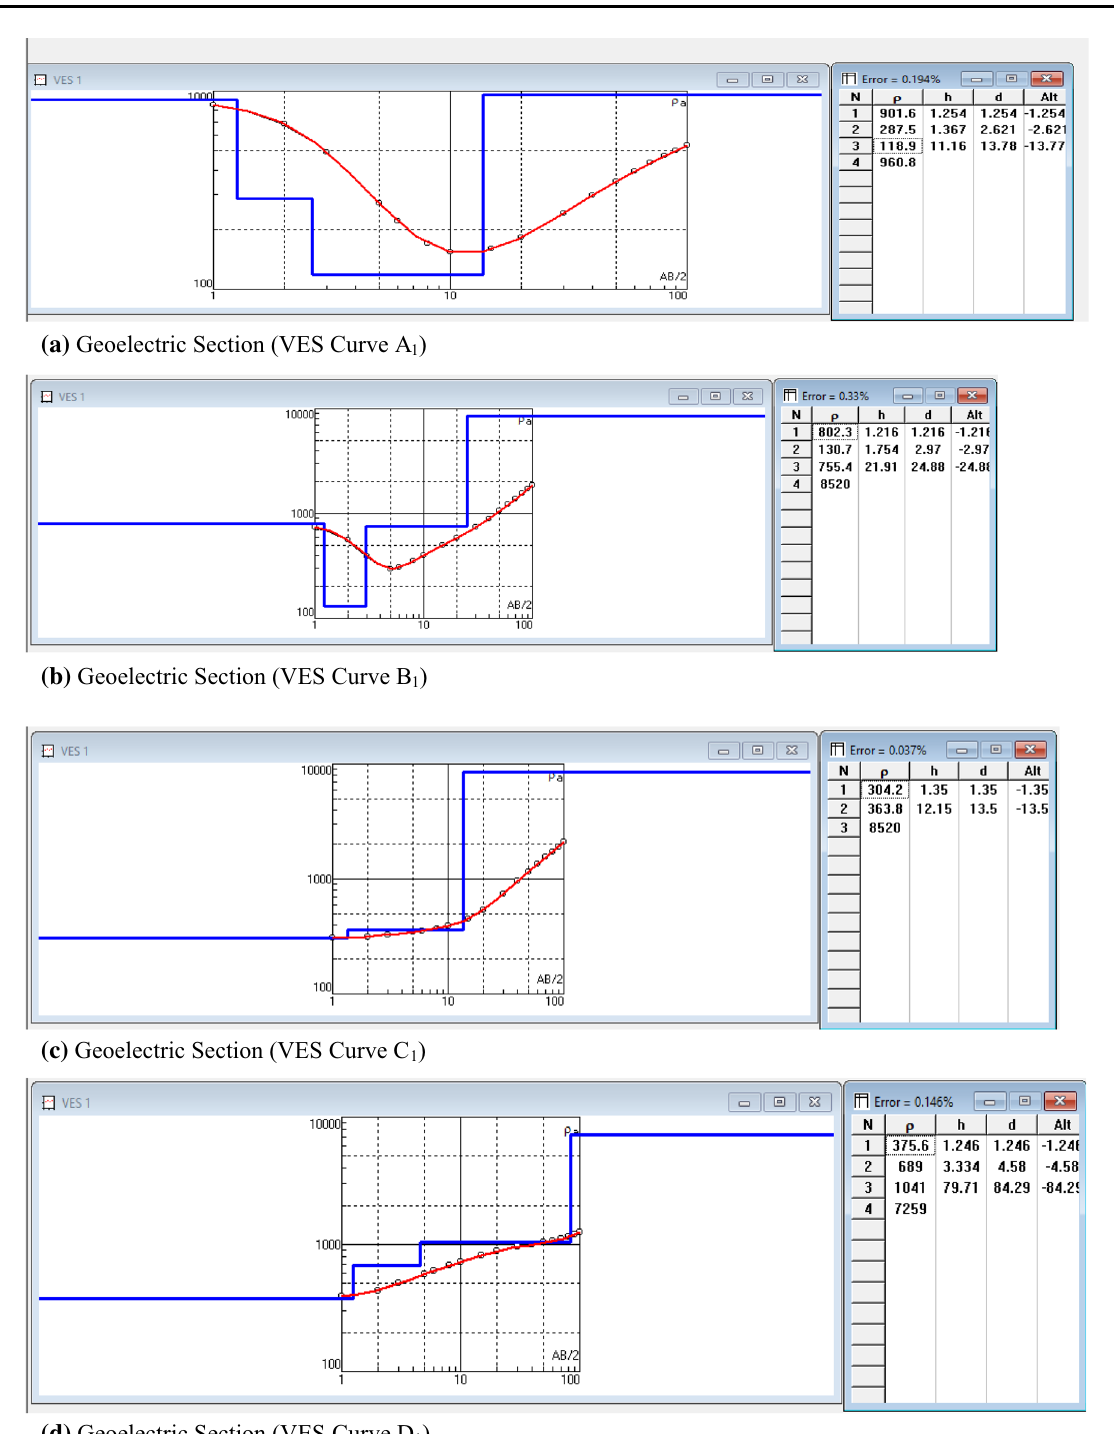
Fig. 2 Geoelectric Section a (VES curve A 1 ), b (VES curve B 1 ), c (VES curve C 1 ), d (VES curve D 1